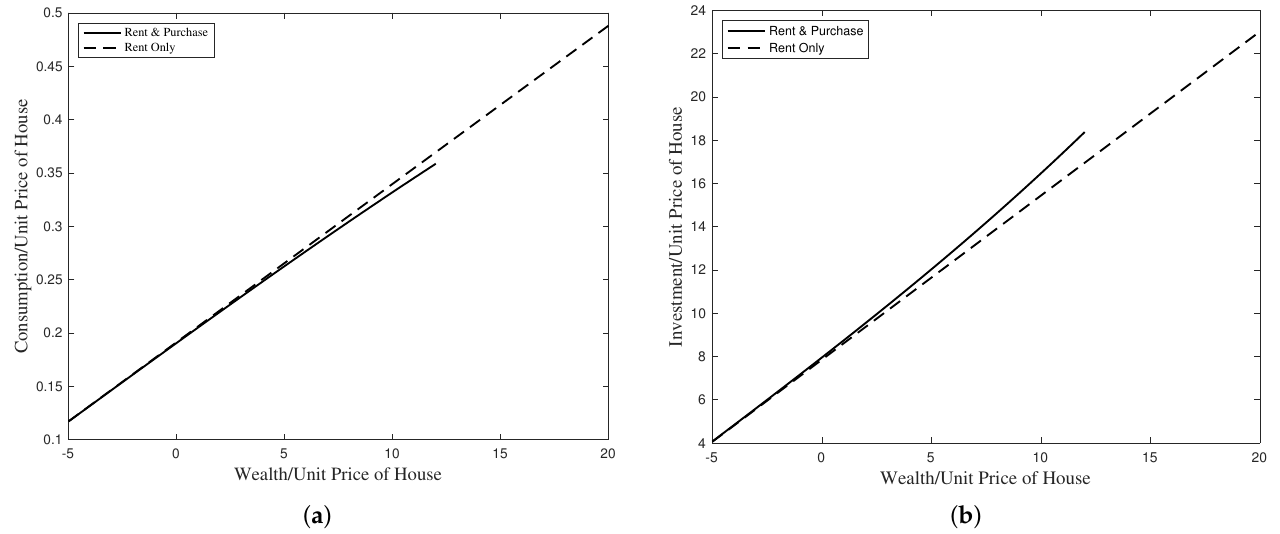
Figure 5. Comparison of optimal consumption and investment policies between purchasing and rent only. ( a ) Consumption. ( b ) Investment.